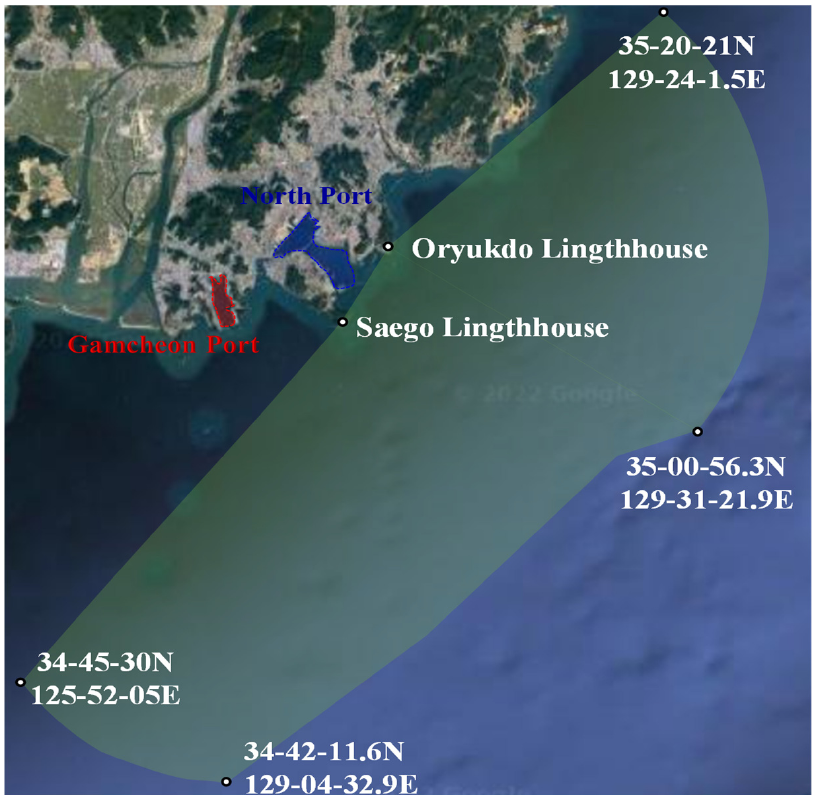
Figure 1. VSR program areas in BP including the NP and GP.